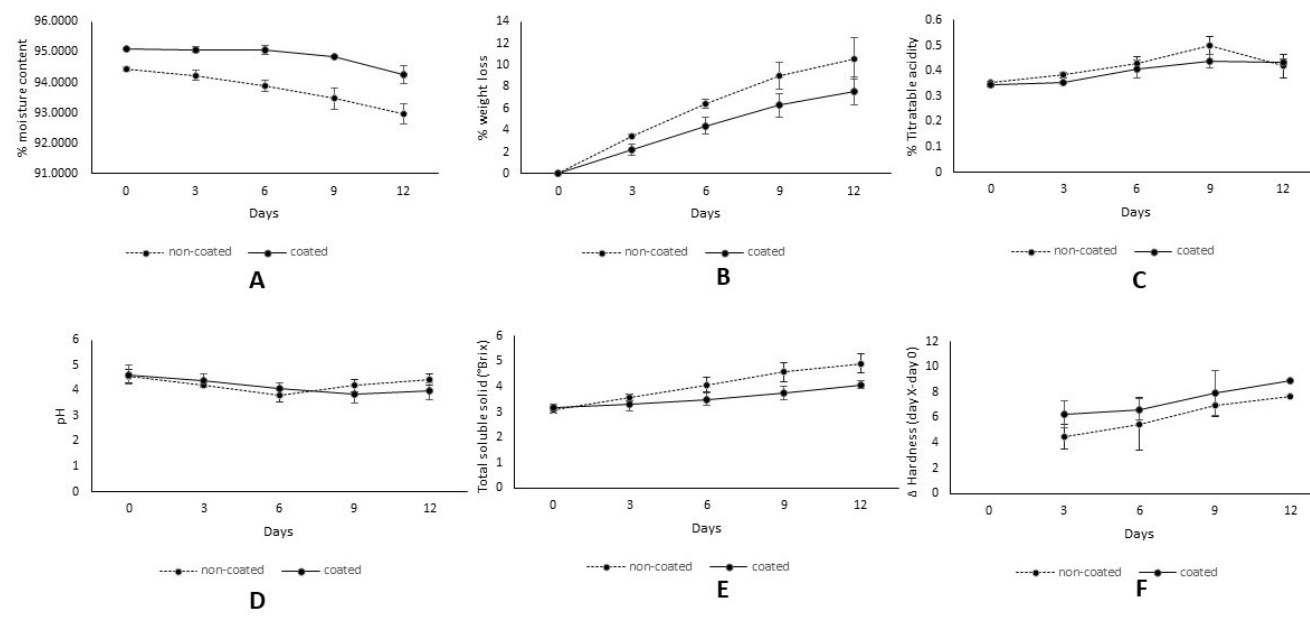
Figure 1. The effect of A. vera edible coating on ( A ) moisture content, ( B ) weight loss, ( C ) titratable acidity, ( D ) pH, ( E ) total soluble solid, and ( F ) hardness of